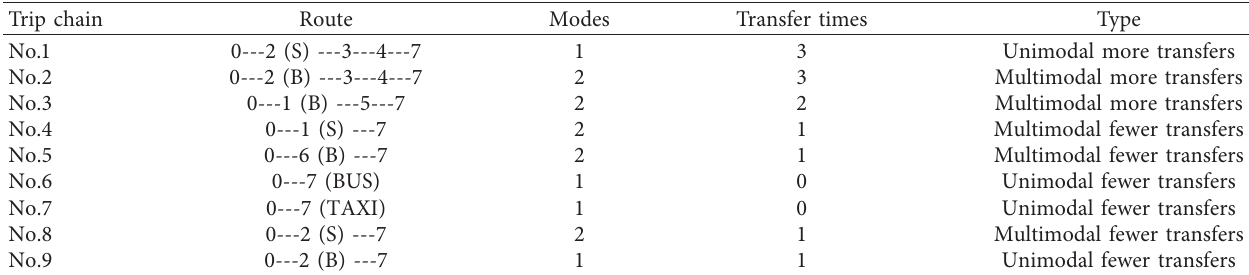
Figure 1: The multimodal trip chains between BCIA and BJXRS. Table 2: Four types of trip chains between BCIA and